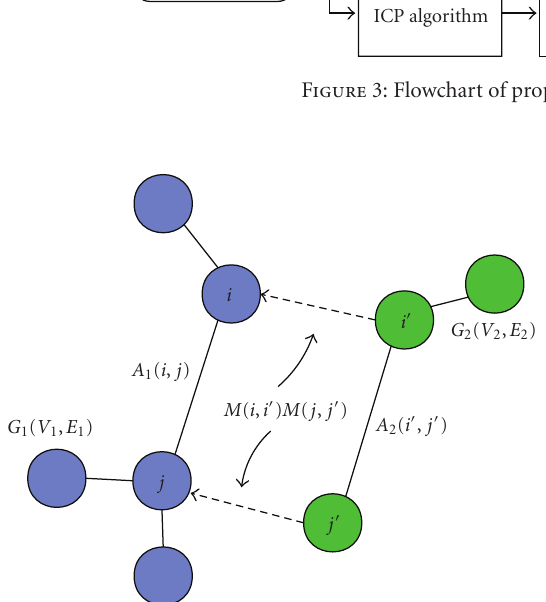
Figure 4: Rectangle rule for subgraph matching, where an assign- ment is found between the node i in G 1 and node i (cid:6) in G 2 , likewise for j and j (cid:6)